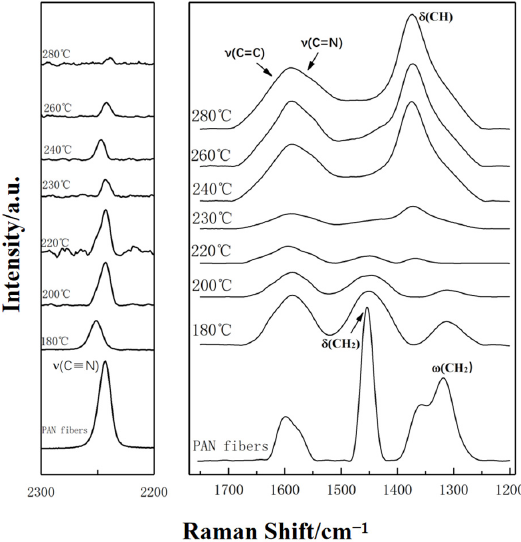
Figure 1. Raman spectra of PAN fibers treated at different thermal stabilization temperatures.